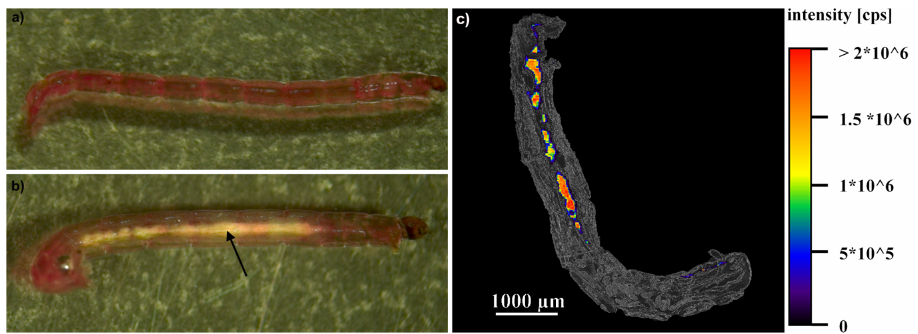
Fig 3. Images of C . riparius larvae. a) photographyof a larva from the control (after 96 h of exposure). b) photography of a larva exposedto 1000 mg/L nano-Al 2 O 3 (after 96 h of exposure). The arrow marks the agglomeration of nano-Al 2 O 3 within the gut. c) overlay of an image of a thin section of a larva (after 96 h of exposureto 1000 mg/L nano-Al 2 O 3 ) at phasecontrast and the aluminumdistributionwithin this section, which was measuredby LA-ICP-MS imagingtechniques.